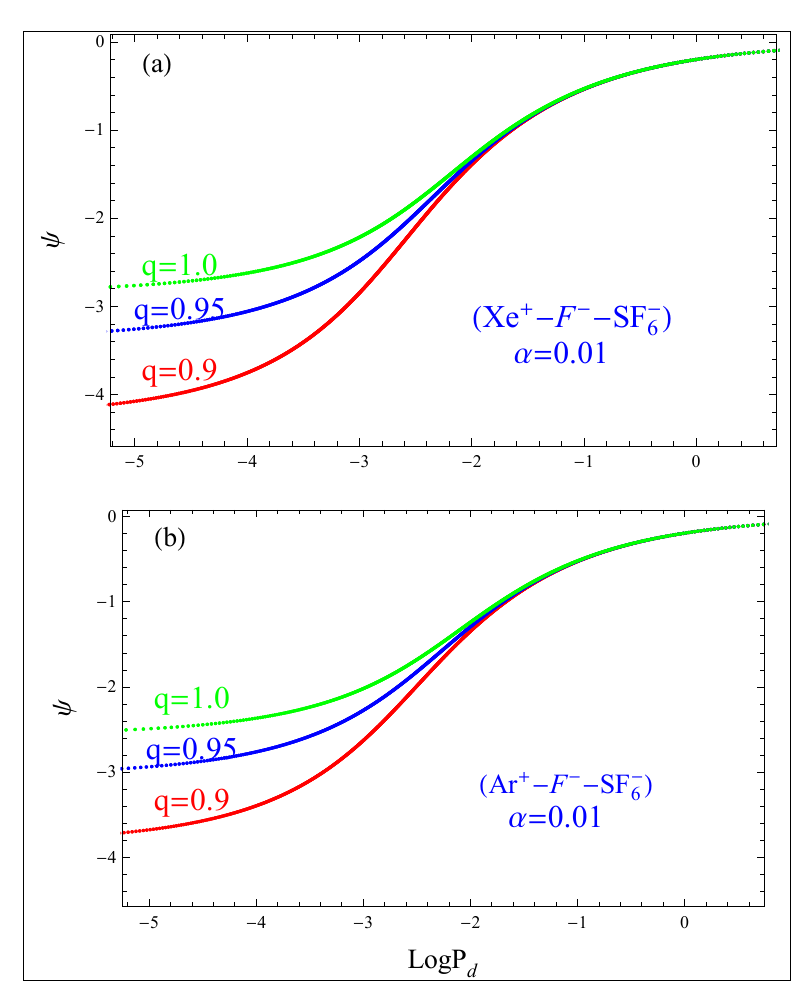
Figure 3. (Color online) ψ versus P d for q ( 0.9,0.95,1.0 ) with α = 0.01; ( a ) xenon–fluorine–sulfur hexafluoride as given in Equation (10) ( b ) for argon–fluorine–sulfur hexafluoride plasma as given in Equation (14)